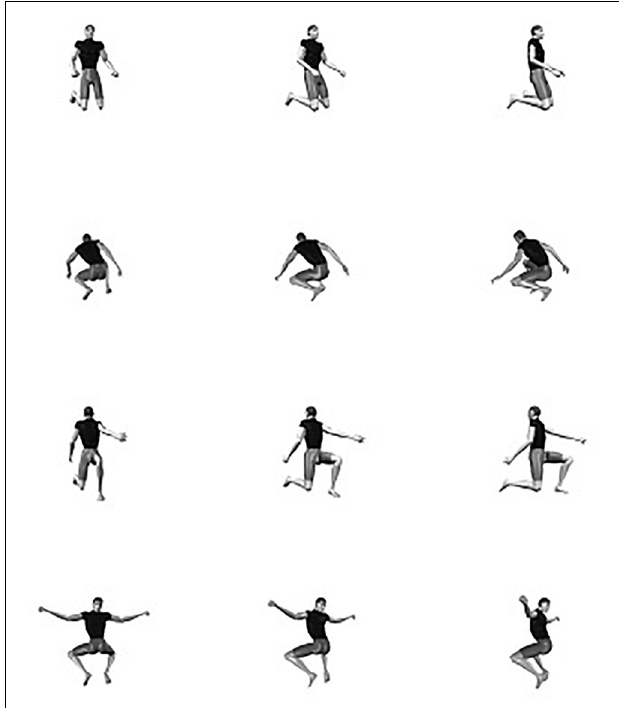
FIGURE 9 | Examples of stimuli used in Experiment 3 (first row: possible posture in 15, 45, and 75 ◦ depth orientation; second row: possible posture in 195, 225, and 255 ◦ orientation; third row: impossible posture with lower body in 15, 45, and 75 ◦ orientation; fourth row: impossible posture with lower body in 195, 225, and 255 ◦